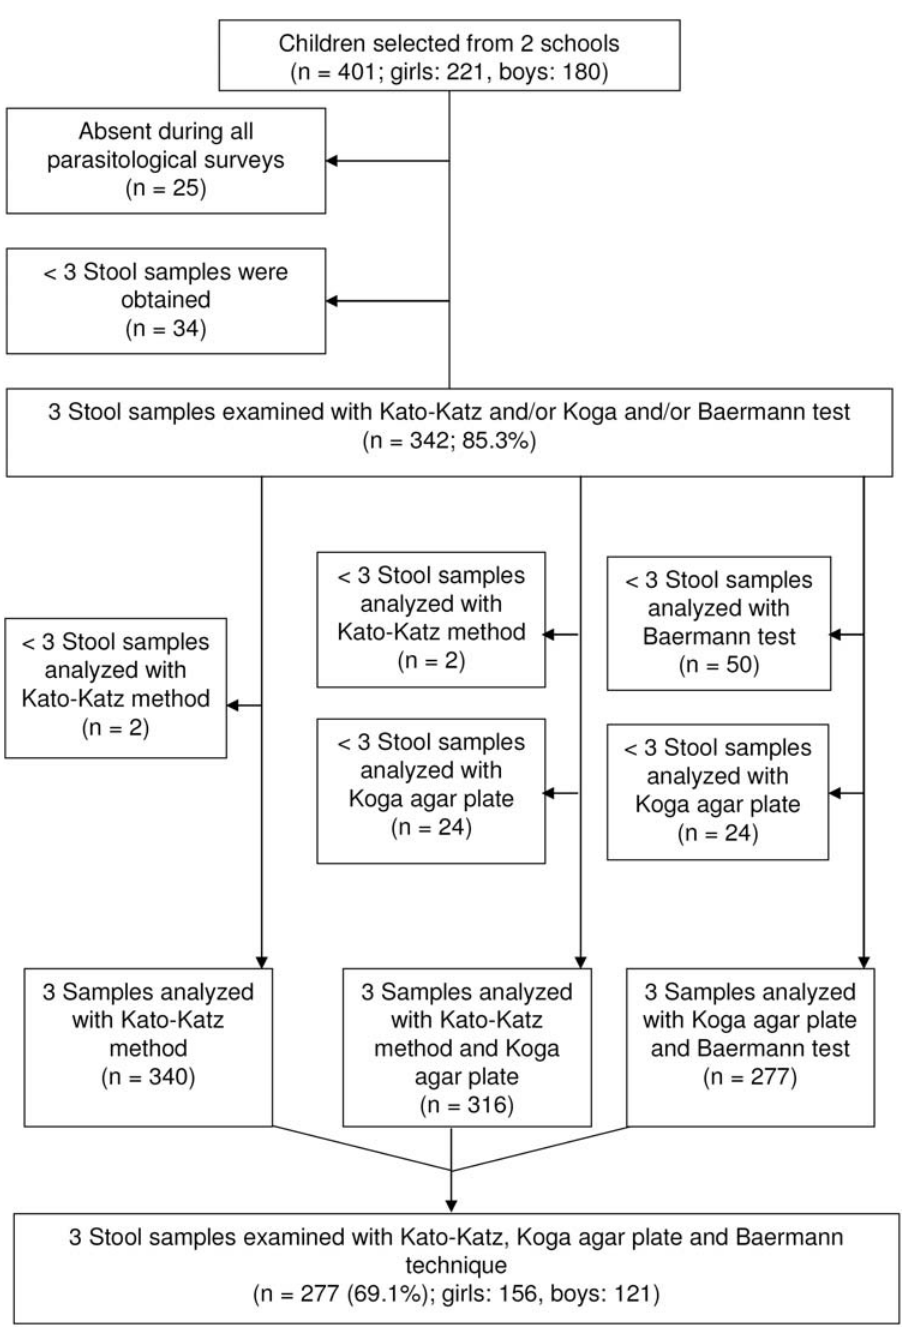
Figure 1. Flow chart detailing the study participation and compliance of randomly selected children from Chaani and Kinyasini schools, Zanzibar. Those children who provided 3 stool samples were included in the final analysis. The final cohort comprised those children who had complete data records, i.e., 3 stool samples examined with 3 different diagnostic methods.